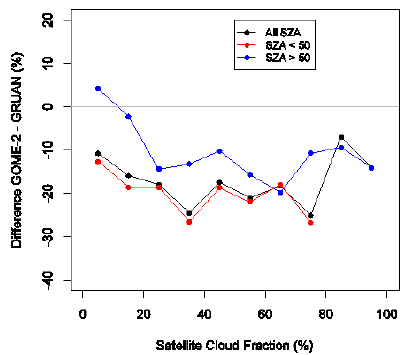
Figure 4. Differences between TWVC data retrieved by GOME- 2 and GRUAN sounding data (Eq. 3) as function of satellite view zenith angle (VZA) for cases with SZA below 50 ◦ .